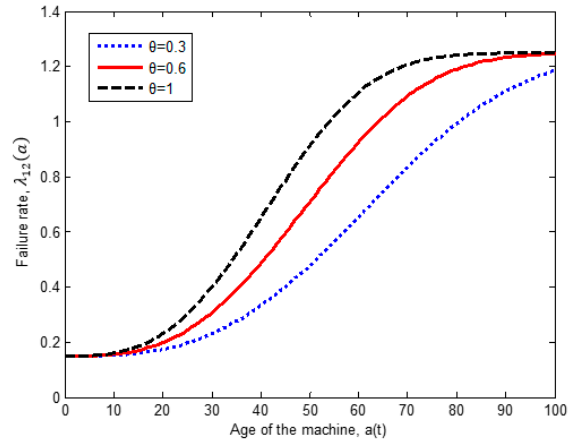
Figure 4. Increasing failure rate.